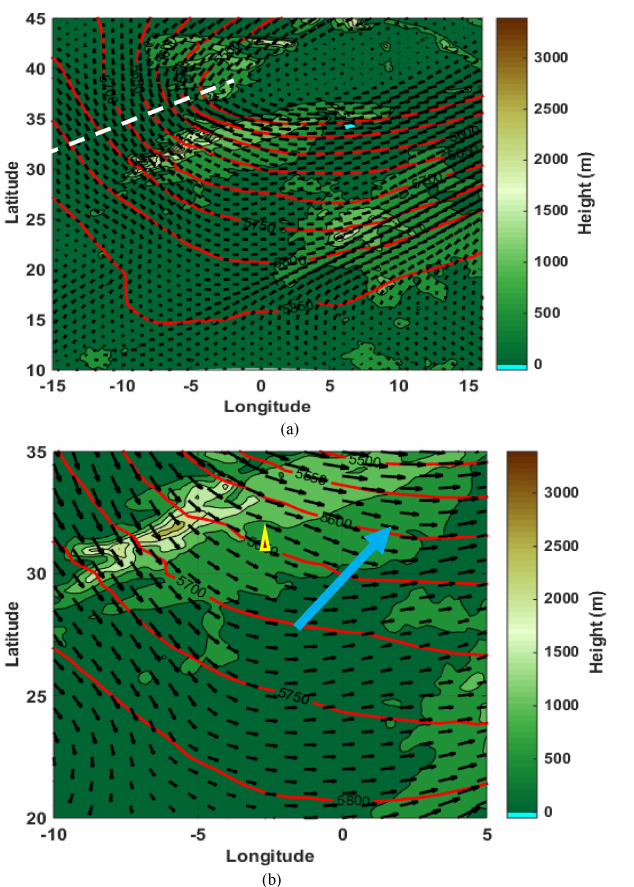
Figure 5. (a) Geopotential height in steps of 50m (red contours), wind speed and direction (small black colored vectors), and the ori- entation of the trough at 00:00UTC on 2 March 2004 at the 500hPa level from MERRA reanalysis with horizontal resolution of 54km (Pokharel, 2016). The shading illustrates the orographic heights in meters. (b) Enlargement of geopotential height in steps of 50m (red contours), wind speed and direction (vectors), and axis of evolving ageostrophic wind (big arrow) at the 500hPa level at 00:00UTC on 2 March 2004 from MERRA reanalysis with horizontal resolu- tion of 54km (Pokharel et al., 2017b). The shading illustrates the orographic heights in meters. A triangle of red (inside) and yellow (outside) shows the location of Bechar where the soundings were